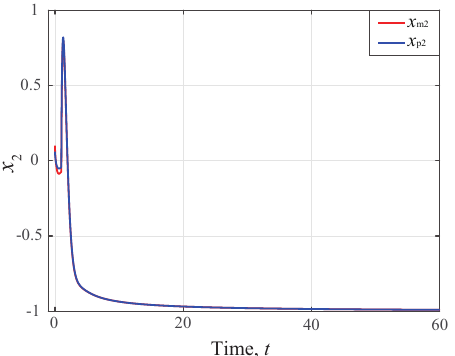
( t ) and x m ( t ) . 2 2